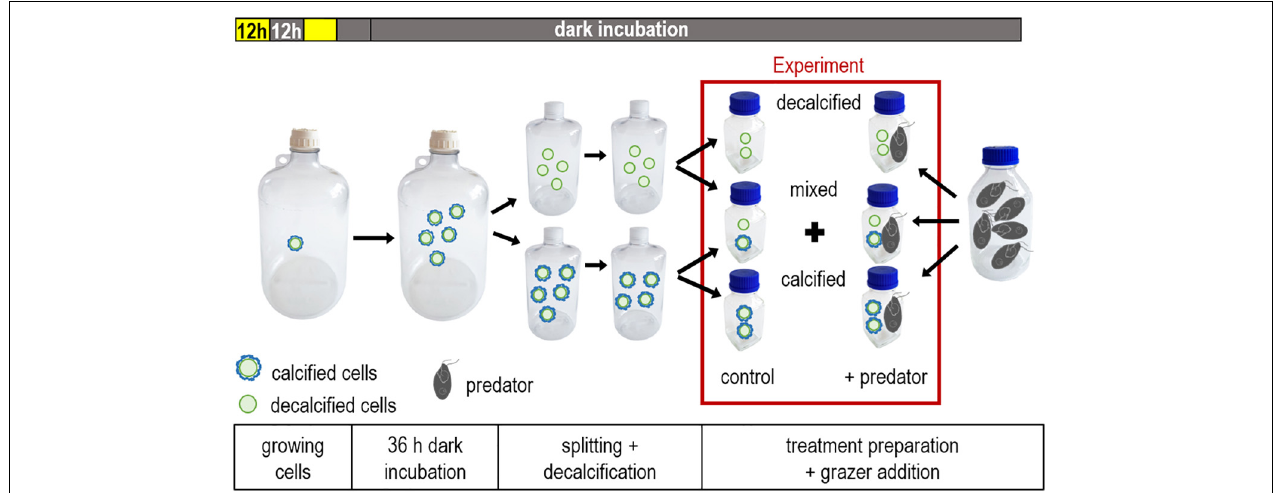
FIGURE 1 | Overview of key steps for preparing each experiment. The coccolithophore cultures were raised to high cell concentrations in a 12:12 hour light-dark cycle followed by a dark incubation of 36 h to terminate growth. The culture was split and decalcified, thereafter treatments (calcified, decalcified and mixed) with approximately equal cell concentrations were prepared. Each experiment started with the addition of the predator. The treatment combinations used in the experiments are highlighted in the red